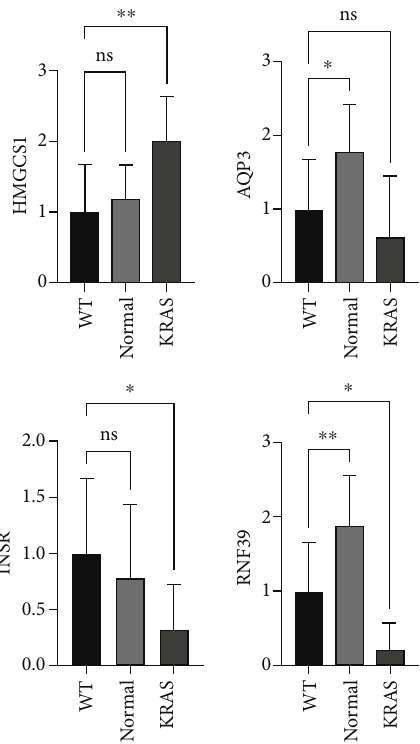
Figure 4: Quantitative RT-PCR verifying the expression of HMGCS1 INSR, RNF39, and AQP3 in the KRAS group, the WT group, and normal paracancerous tissues. ∗ p < 0 : 05 ; ∗∗ p < 0 : 01 ; ∗∗∗ p < 0 : 001 ; ∗∗∗∗ p < 0 : 0001